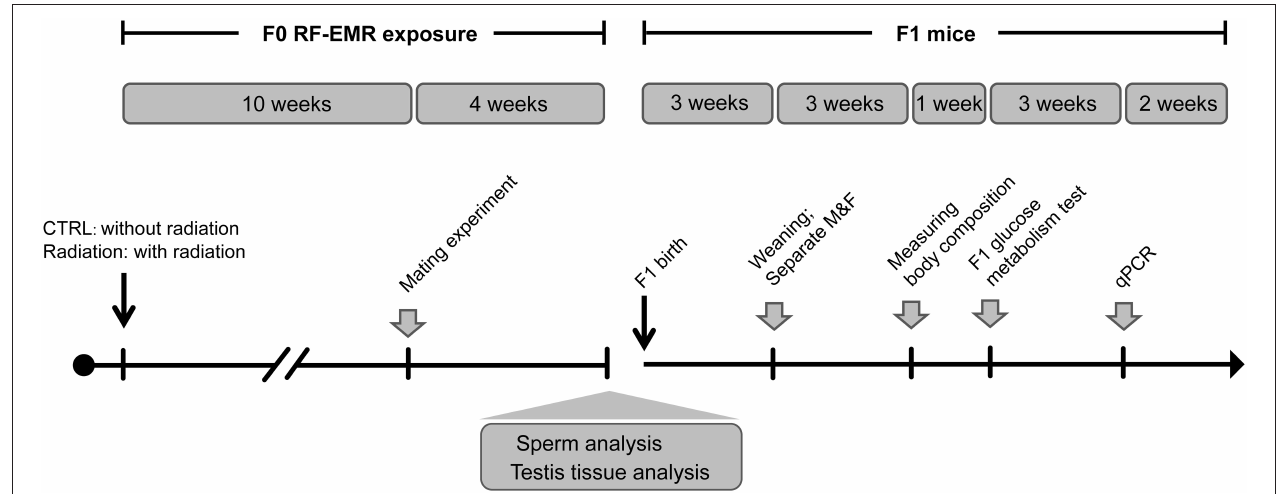
FIGURE 1 | Experiment design of longitudinal mouse exposure study. RF-EMR, radiofrequency electromagnetic radiation. CTRL, mice in sham group; Radiation, mice in RF-EMR exposure group; M, male F1 mice; F, female F1 mice.